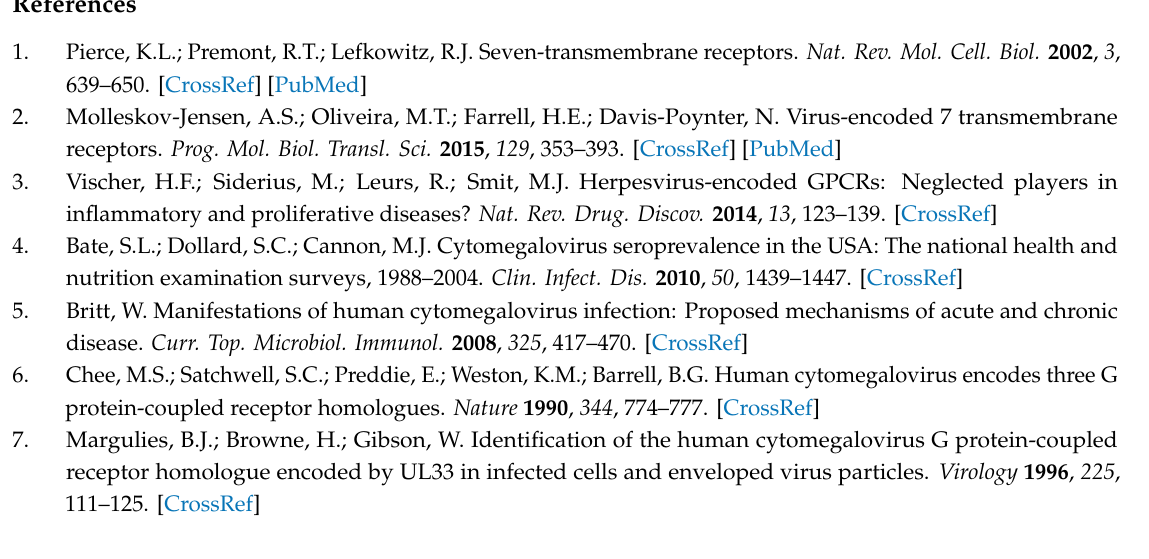
Figure S1: Validation of recombineering strategy and genomic integrity of HCMV Merlin BAC variants., Figure S2: Multiple sequence alignment of HCMV UL33